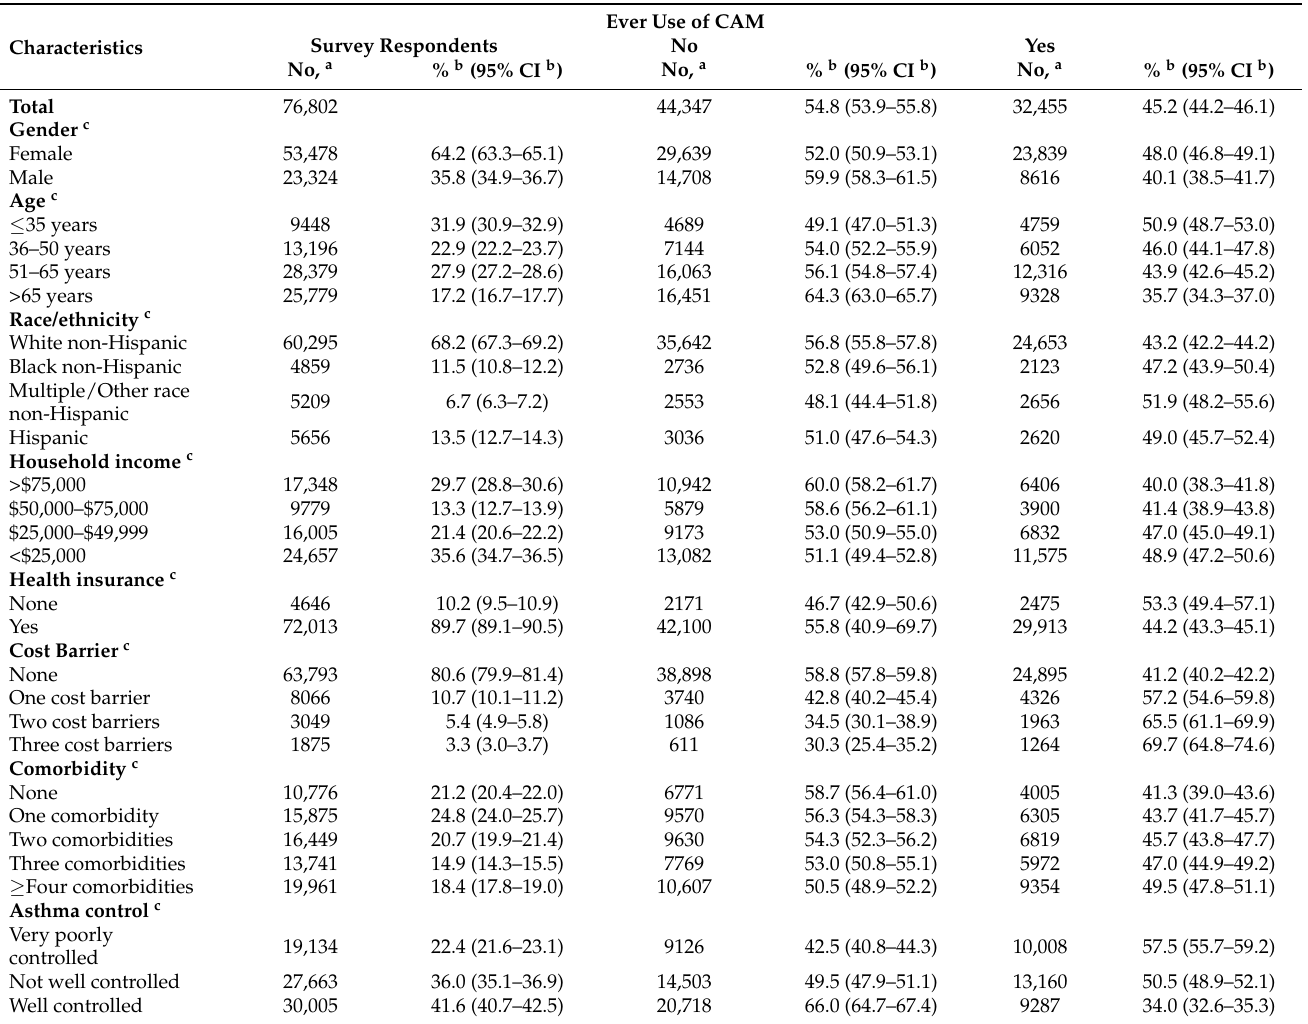
Table 1. Sociodemographic and health factors among US adults with current asthma: Behavioral Risk Factor Surveillance System Asthma Call-back Survey,